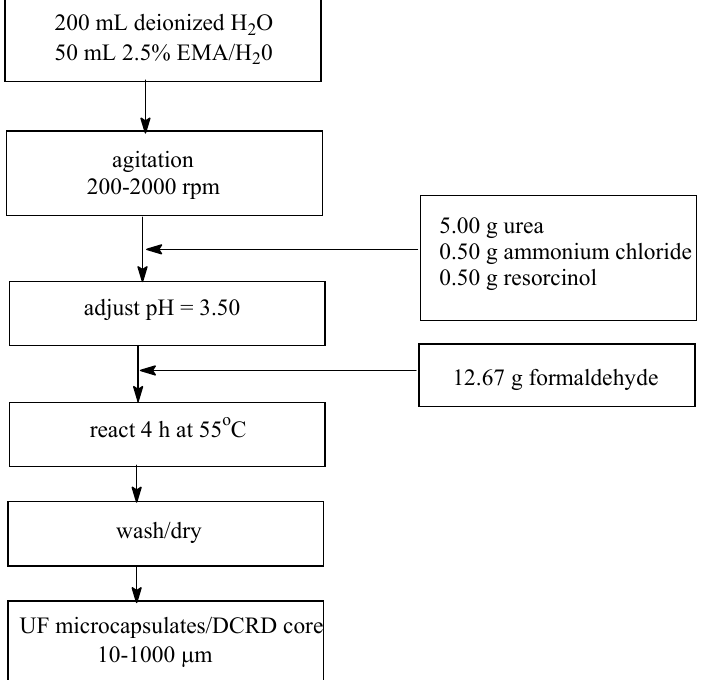
Figure 11. Microencapsulation of DCPD using acid-catalyzed in situ polymerization of urea with formaldehyde to form the capsule wall. EMA is ethylene maleic anhydride. Reproduced from [130] with permission from Taylor & Francis.